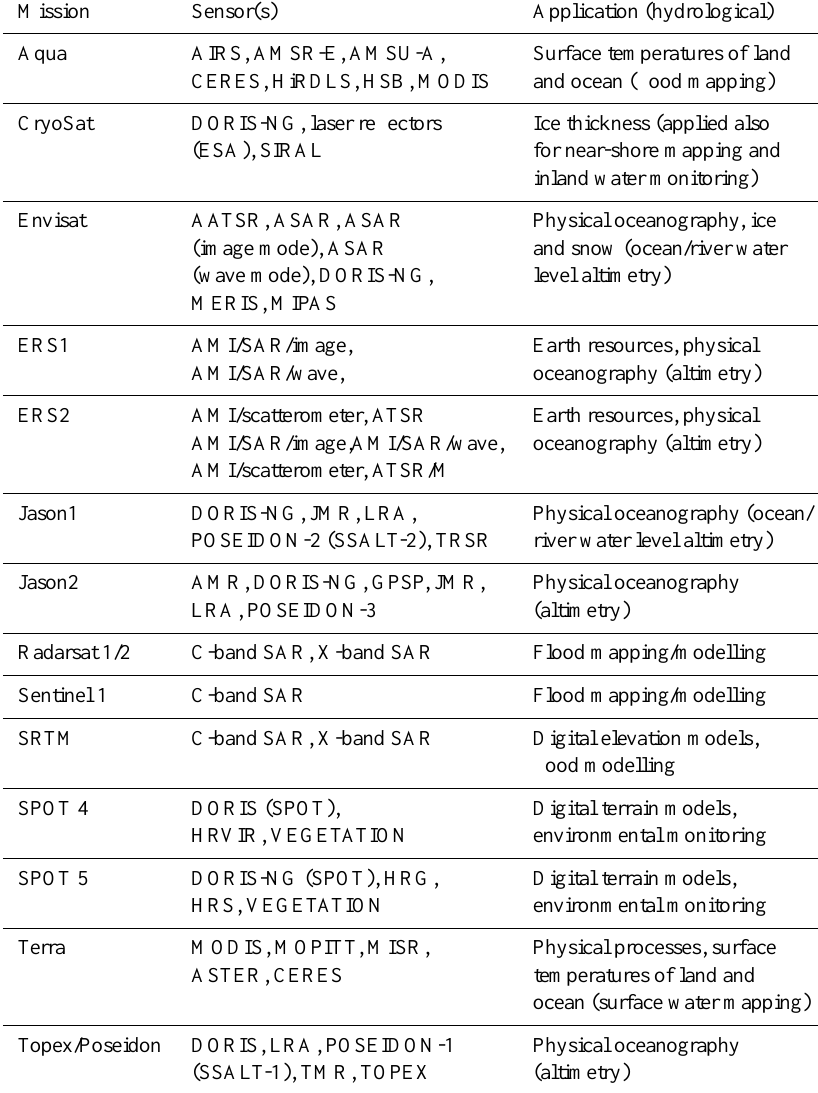
Table 1. Some satellite missions and sensors used for hydrological